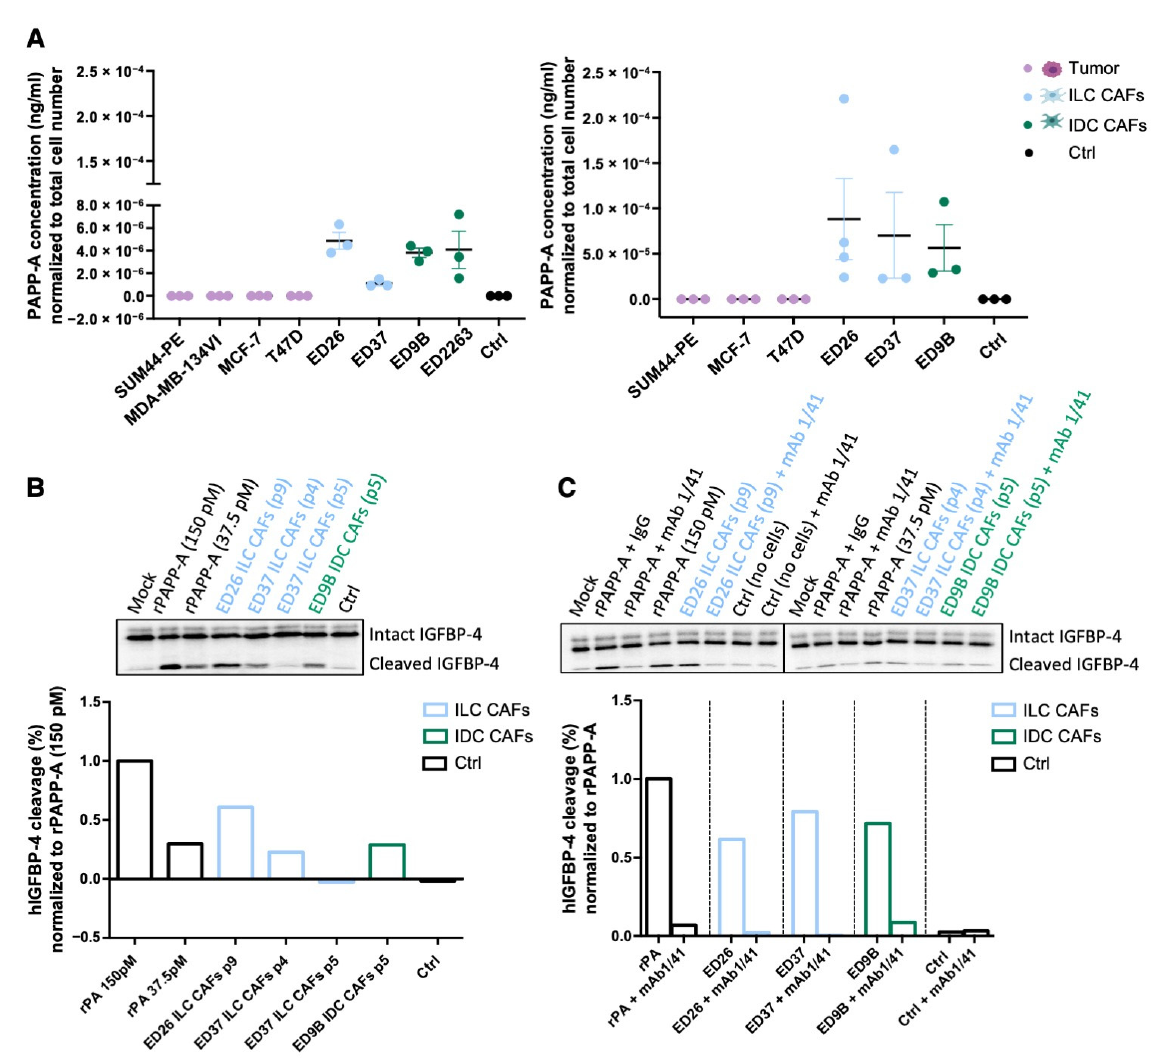
Figure 6. Active PAPP-A is secreted from CAFs. ( A ) ELISA of PAPP-A secreted from a series of ILC and IDC cell lines and primary CAFs. Conditioned medium (CM) was collected after 24 h (left panels) or after 48 h from the tumor cells and 96 h from the CAFs (right panels). PAPP-A concentration was normalized to total cell number (n = 3). ( B ) PAPP-A-mediated IGFBP-4 cleavage. CM from ILC and IDC primary CAFs was incubated with radiolabeled IGFBP-4 for 1, 2 and 4 h. Recombinant PAPP-A (rPAPP-A) was used as a positive control. Quantification at 4 h is represented as the percentage of human IGFBP-4 cleavage normalized to recombinant PAPP-A (150 pM). ( C ) IGFBP-4 cleavage was measured in the presence of PAPP-A inhibitory antibody (mAb 1/41) or isotype control (IgG) in CM from ILC and IDC CAFs. Quantification at 4 h is represented as the percentage of human IGFBP-4 cleavage normalized to the corresponding recombinant PAPP-A (150 pM or 37 pM). p denotes passage number of the